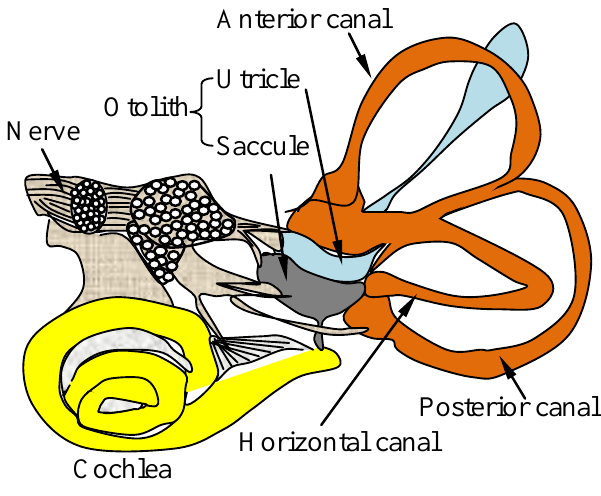
Figure 2. Schematic of the human vestibular system showing the three perpendicular semi-canals and the otolith (utricle and saccule) in the inner